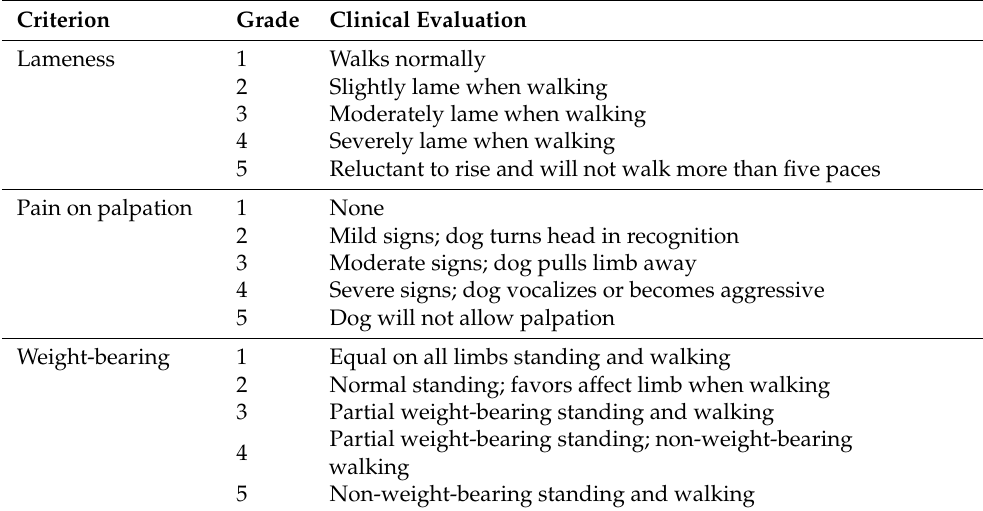
Table 1. Clinical lameness scoring system. Adapted with the permission from Ref. [10]. 2013, the Korean Society of Veterinary